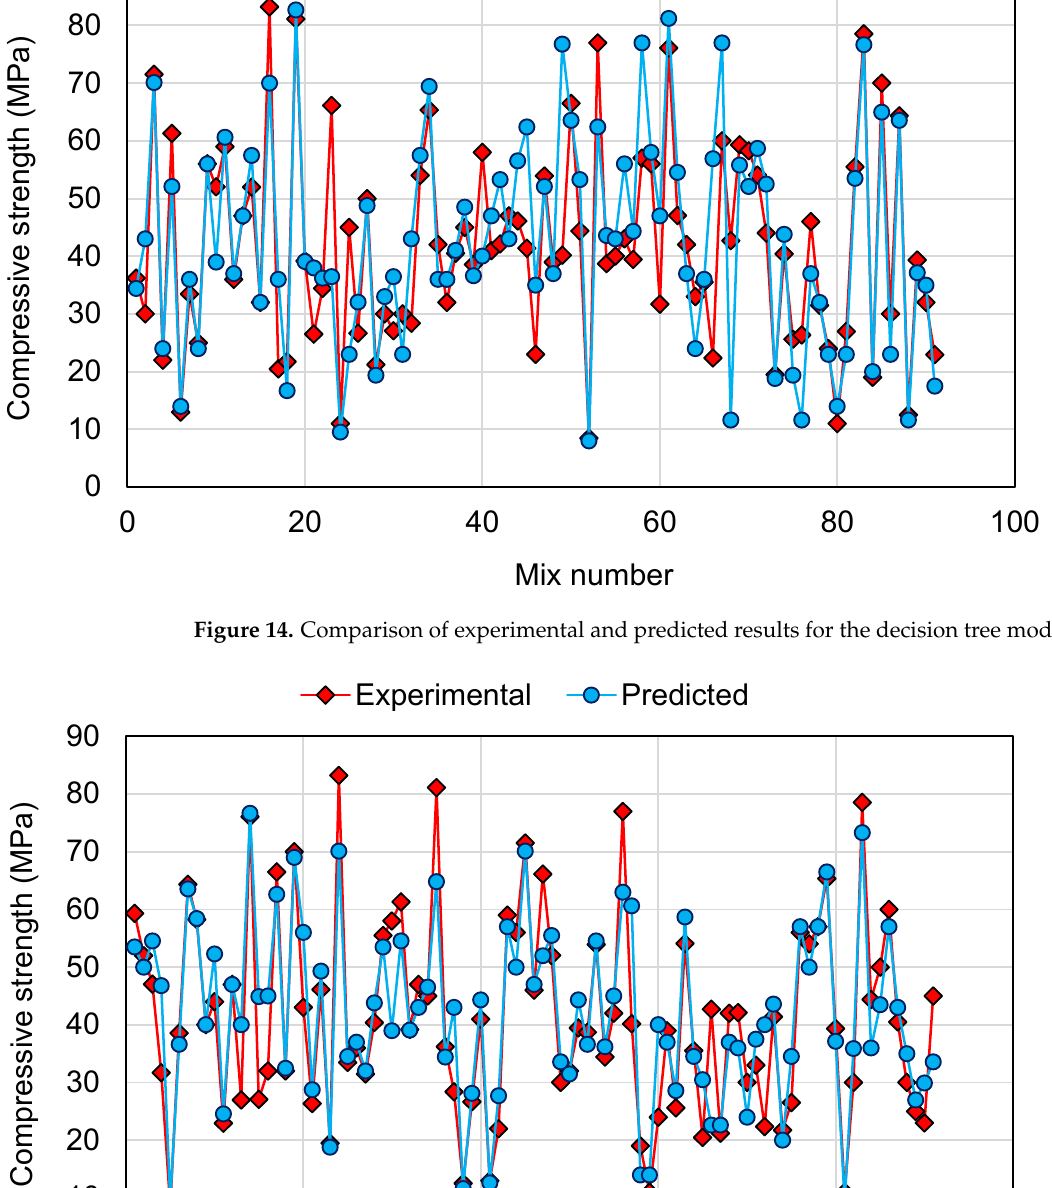
Figure 16. Comparison of experimental and predicted results for the random forest model. 7. Conclusions The intention of this research was to employ both individual and ensemble machine learning (ML) algorithms to anticipate the compressive strength (CS) of geopolymer composites (GPCs). To forecast outcomes, one individual technique, decision tree (DT),